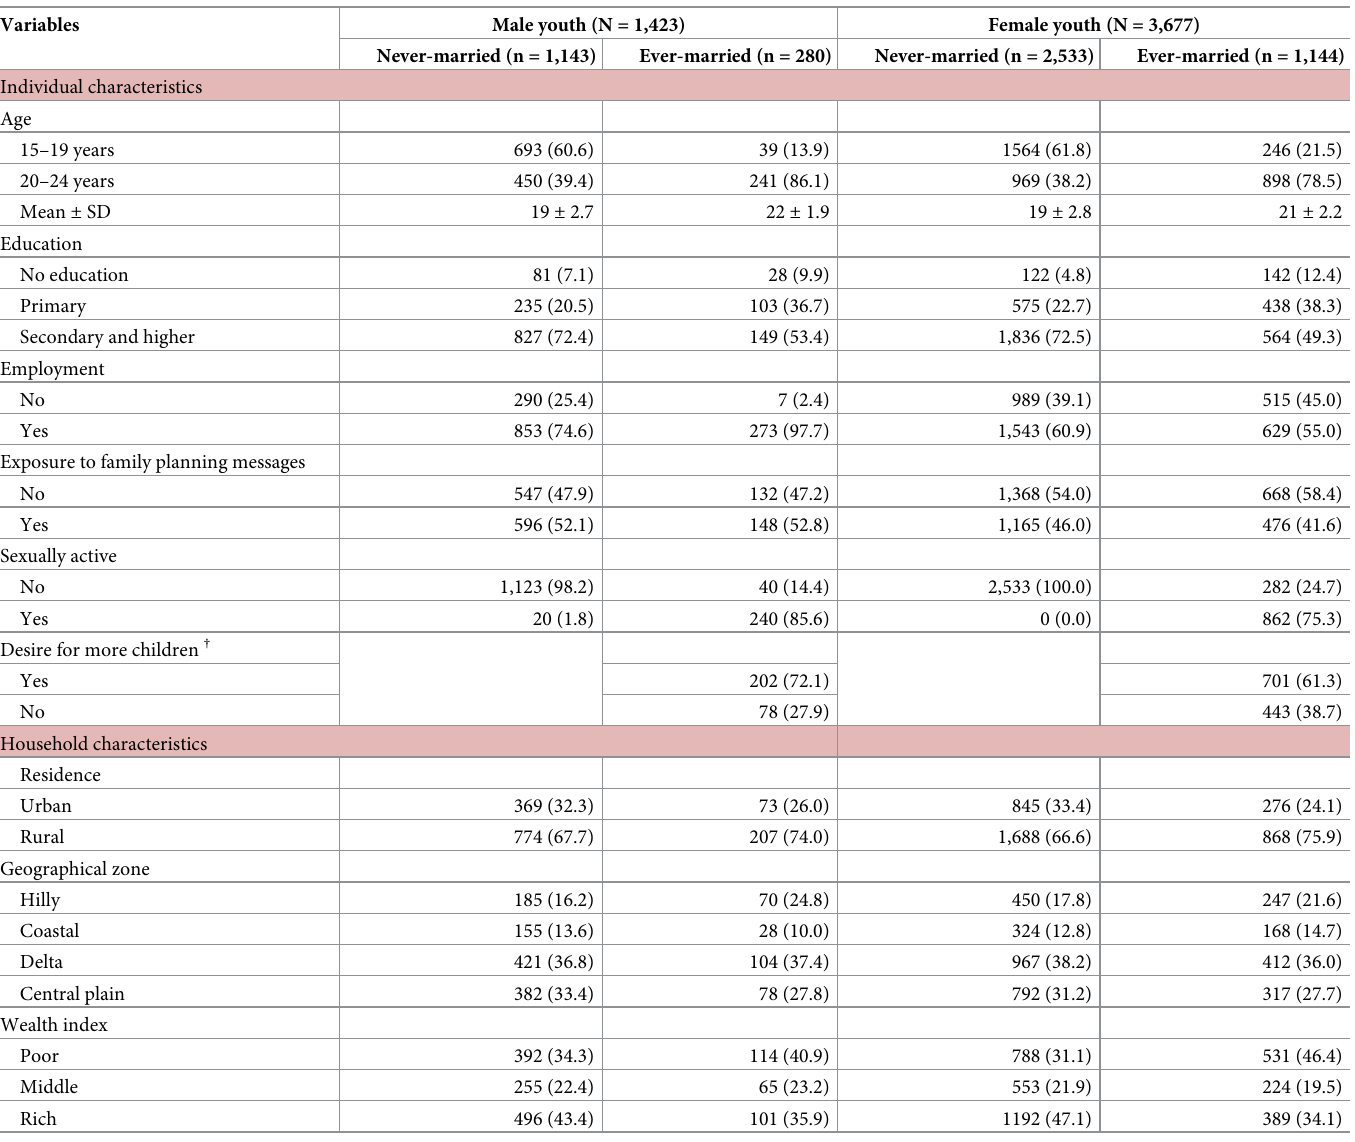
Table 1. The individual and household characteristics of youth in